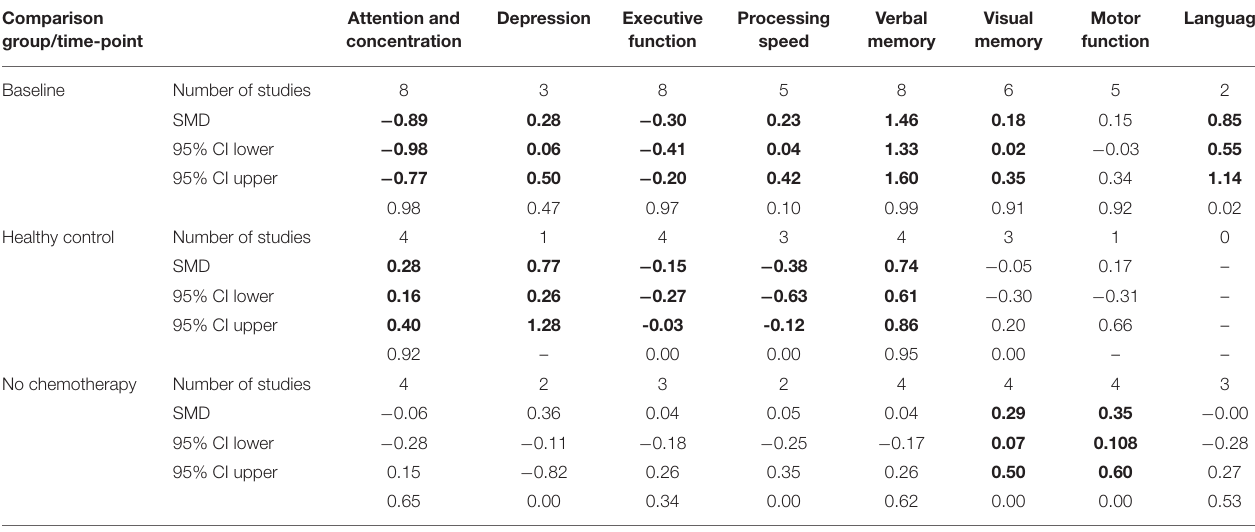
TABLE 4 | Collective results for cognitive domain by comparison method using fixed effect model (in bold p < 0.005). Comparison group/time-point